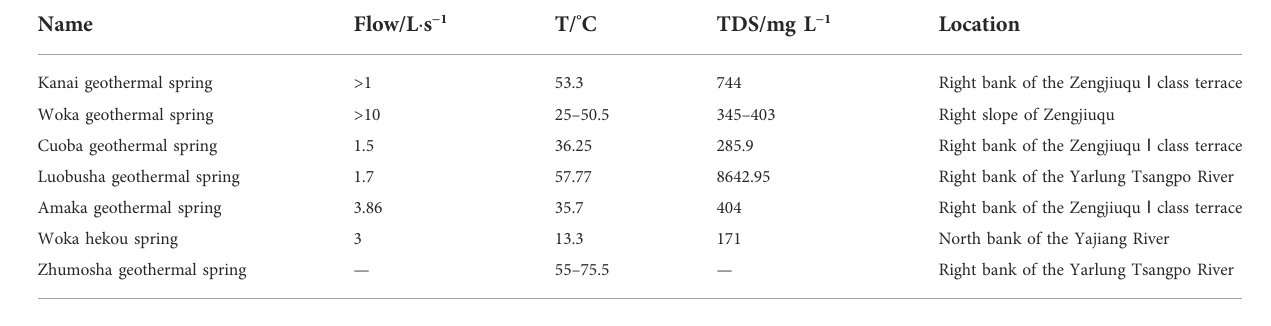
TABLE 1 Exposure characteristics of geothermal springs.